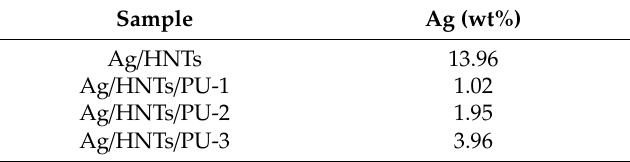
Figure 4. EDS images of the Ag / HNTs / PUs ( a ) PU ( b ) Ag / HNTs / PU-1 ( c ) Ag / HNTs / PU-2 ( d ) Ag / HNTs / PU-3. Table 2. The EDS results of Ag / HNTs and Ag / HNTs /